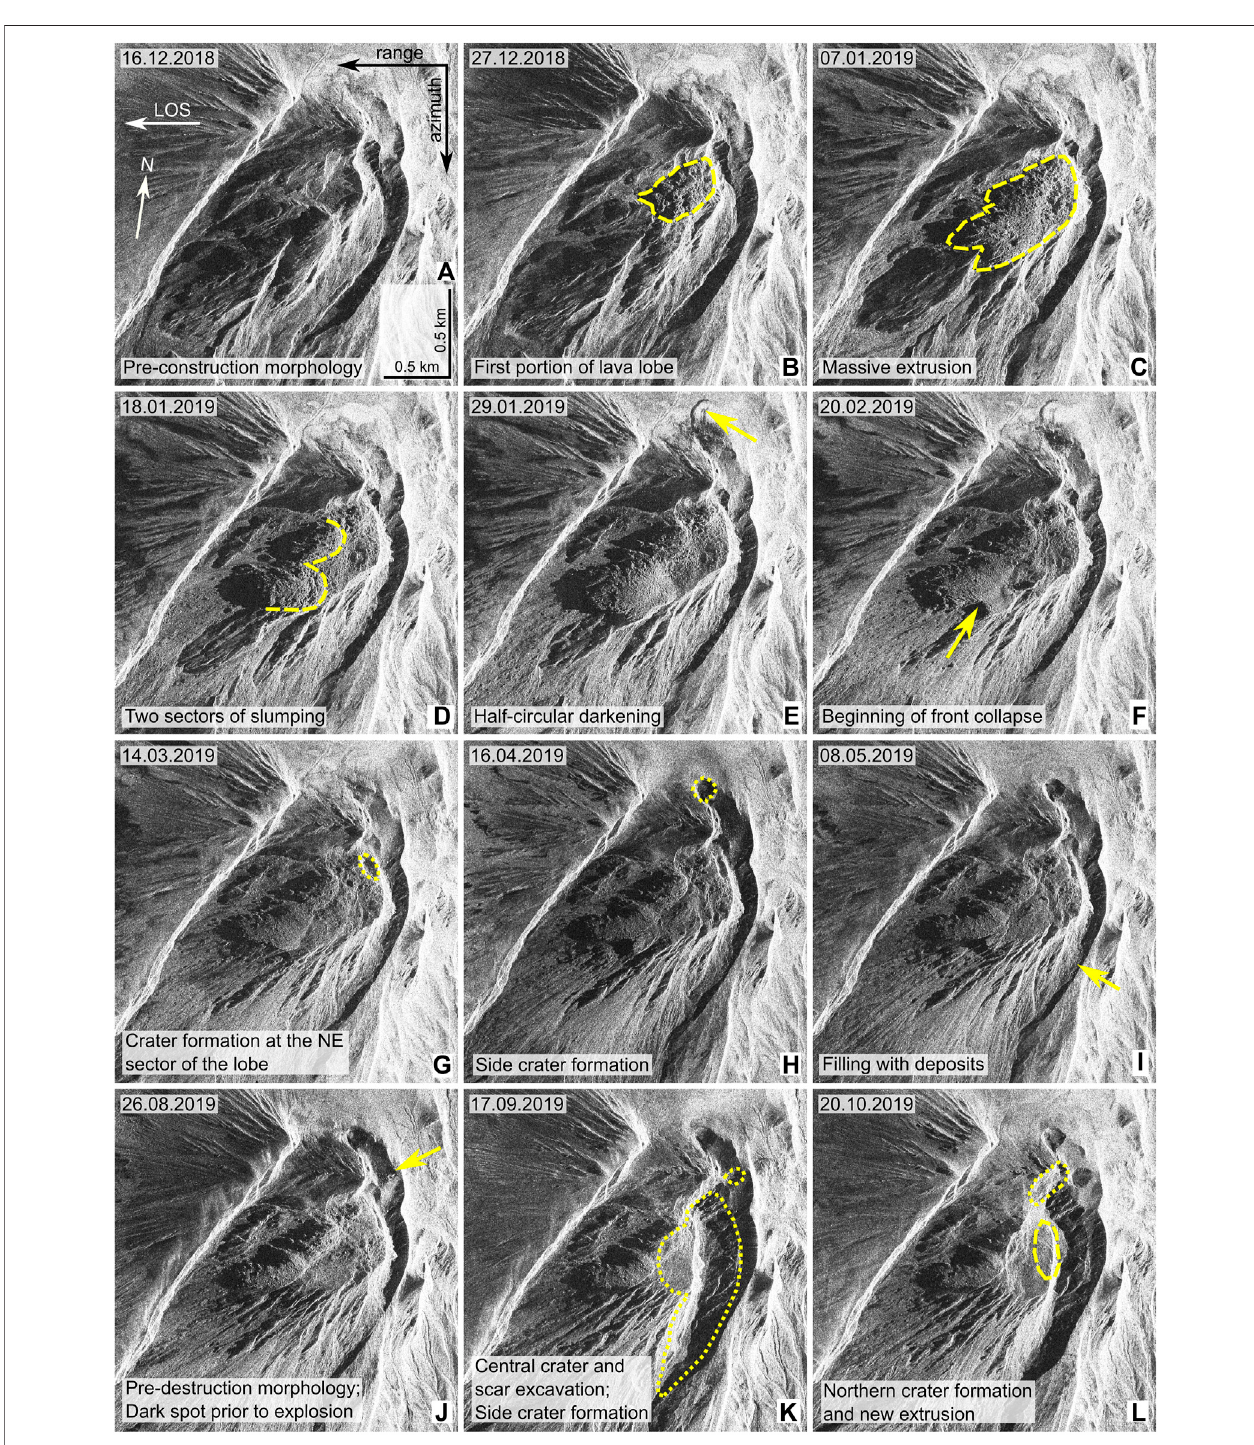
FIGURE 7 | Time series of TSX descending orbit amplitude images (in radar coordinates: azimuth and range) showing the chronology of the eruptive events and main morphological changes that occurred over the studied period. Low-amplitude features (craters and scars) are shown with dotted lines; high-amplitude features (extrusive bodies) are shown with dashed lines. Arrows point to the features labeled in the bottom left corners of the images.